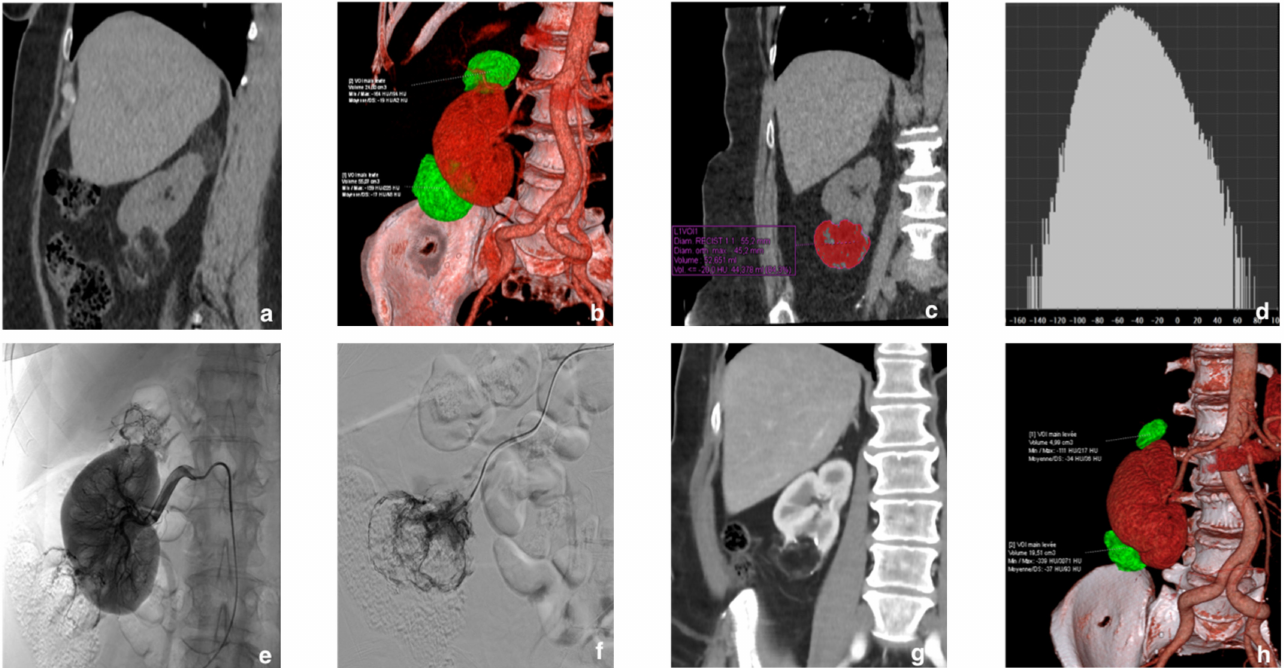
Figure 3. Example of a 58-year-old woman with no history of tuberous sclerosis. ( a ) Two fat-rich renal angiomyolipomas (rAMLs) were discovered in the right kidney during computed tomography (CT) done for other reasons. ( b ) The volume- rendering reconstruction shows the two right polar rAMLs. ( c , d ) Coronal CT image with tumor segmentation and a density histogram: note the large fat component of the lower polar lesion, estimated at 84.3%. ( e ) Selective prophylactic arterial embolization was decided. The right renal angiography shows the rAMLs at the upper and lower poles. ( f ) After superselective catheterization and angiography of both rAMLs, the injection of a mixture of Glubran ® 2 and Lipiodol in a 1:6 ratio achieved complete devascularization of both tumors. ( g , h ) Contrast-enhanced control CT at 17 months with volume rendering showed an excellent result with 79.8% and 64% volume reductions of the upper and lower rAMLs,